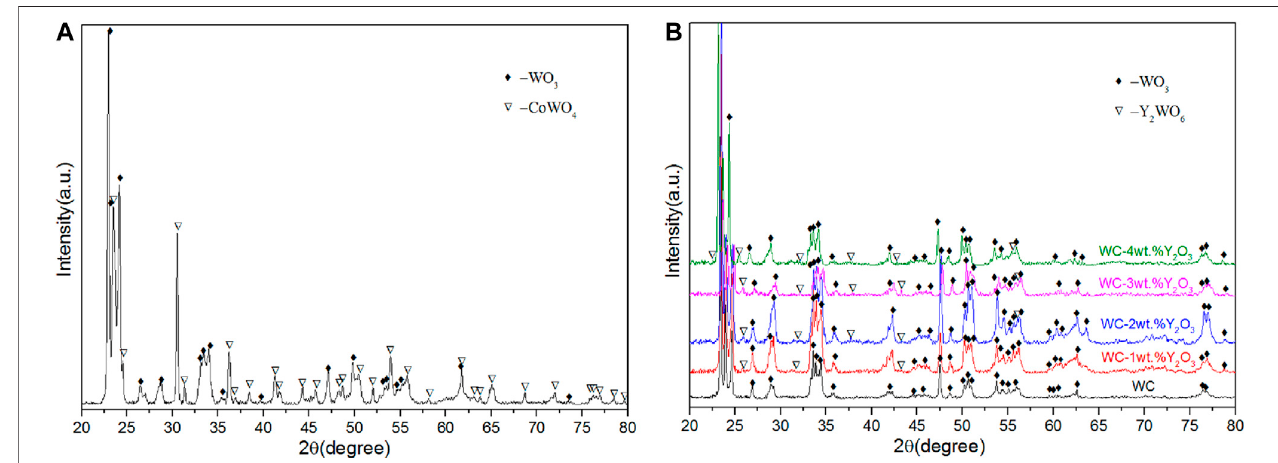
FIGURE 5 | XRD patterns of the surface of oxidation layer of YG3 cemented carbide (A) and binderless tungsten carbide with different Y 2 O 3 contents (B) .